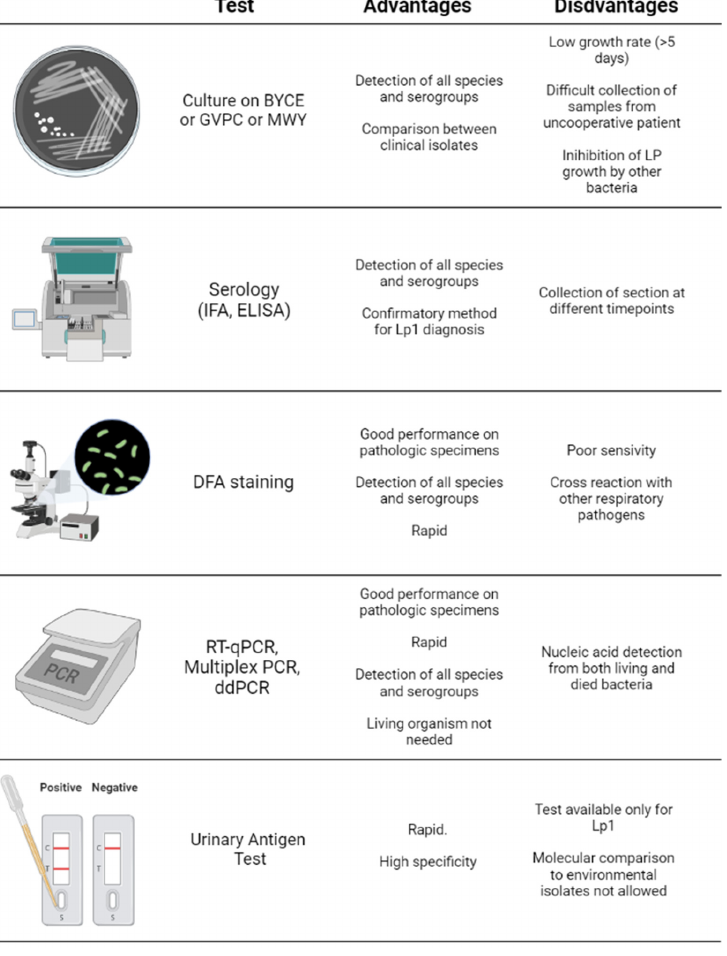
Figure 2. Advantages and pitfalls of the culture, serological and molecular methods for the diagnosis of legionellosis.